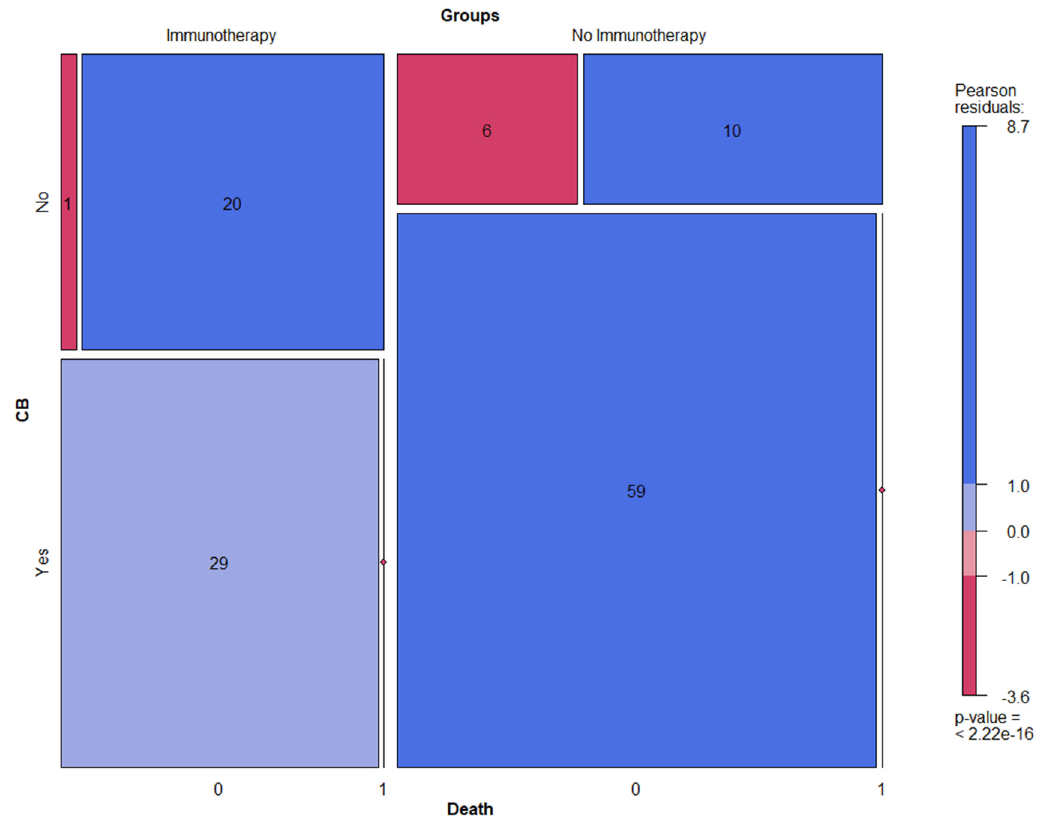
Figure 3. Mosaic plots displaying clinical benefit (CB) and mortality rate in NSCLC patients treated with ICI vs. no ICI. with ICI vs. no